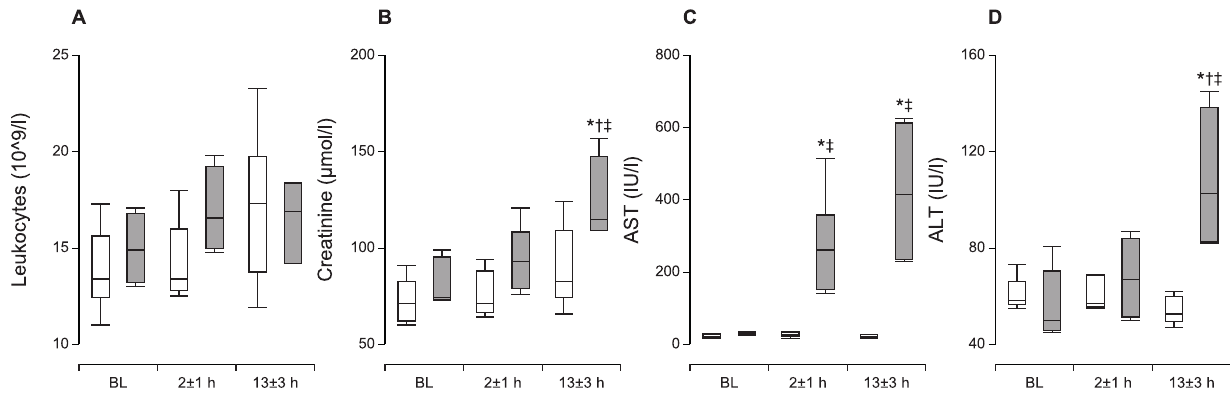
Figure 4. Indicators of Organ Damage. A: Circulating leukocyte levels were similar between groups, indicating the absence of any major inflammatory response after coronary microembolization (CME). B: Creatinine levels increased following CME, in parallel with the kidney failure evidenced by oliguria/anuria. C–D: Hepatic aspartate (AST) and alanine (ALT) transaminase levels increased after CME, indicating hepatocellular damage. The data are presented as median 6 range. Open box plots, time-matched control group; filled box plots, cardiogenic shock group. * p , 0.05 within group compared to baseline, { p , 0.05 within group compared to 2 6 1 hours, ` p , 0.05 between groups.